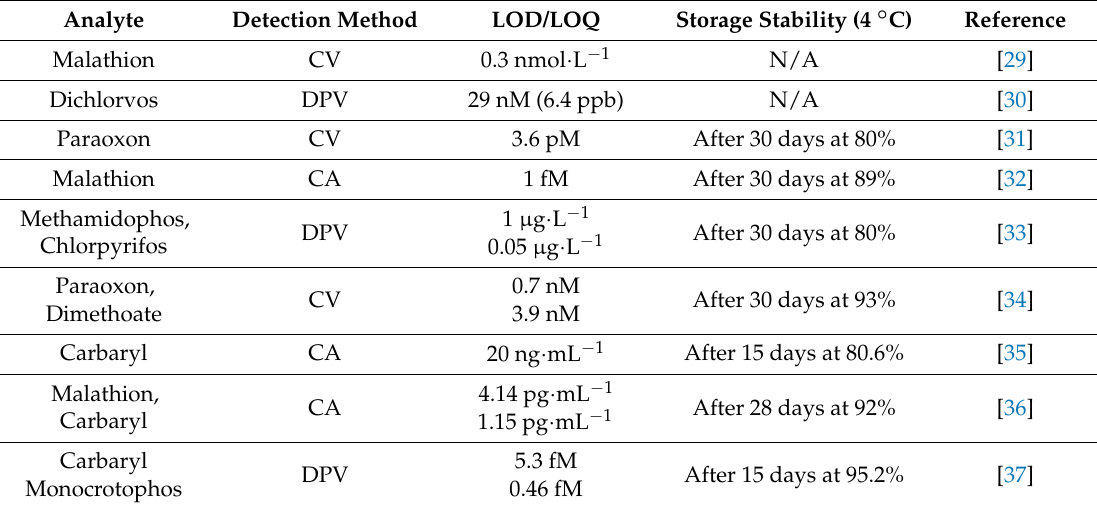
Table 2. Detection of pesticide by acetylcholinesterase inhibition based enzymatic biosensors (CA: Chronoamperometry, CV: Cyclic voltammetry, DPV: Differential Pulse